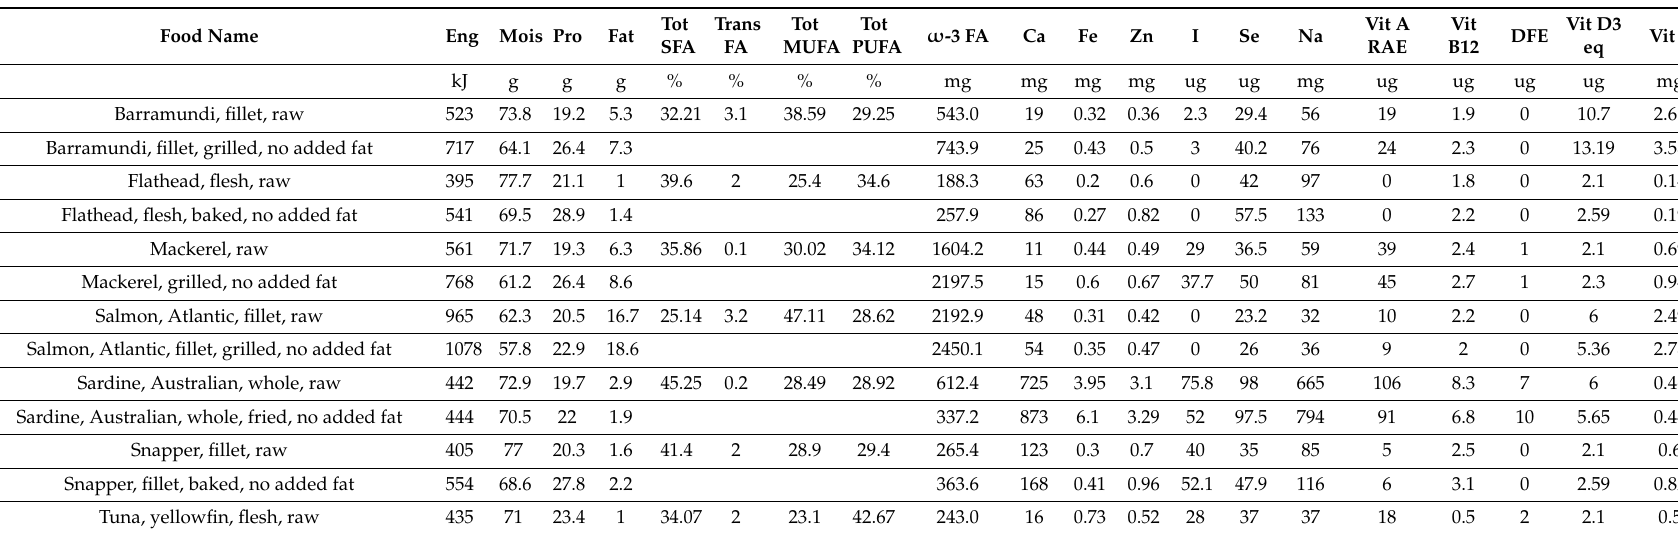
Table A2. Nutrient composition of selected fresh and processed fish and seafood products in